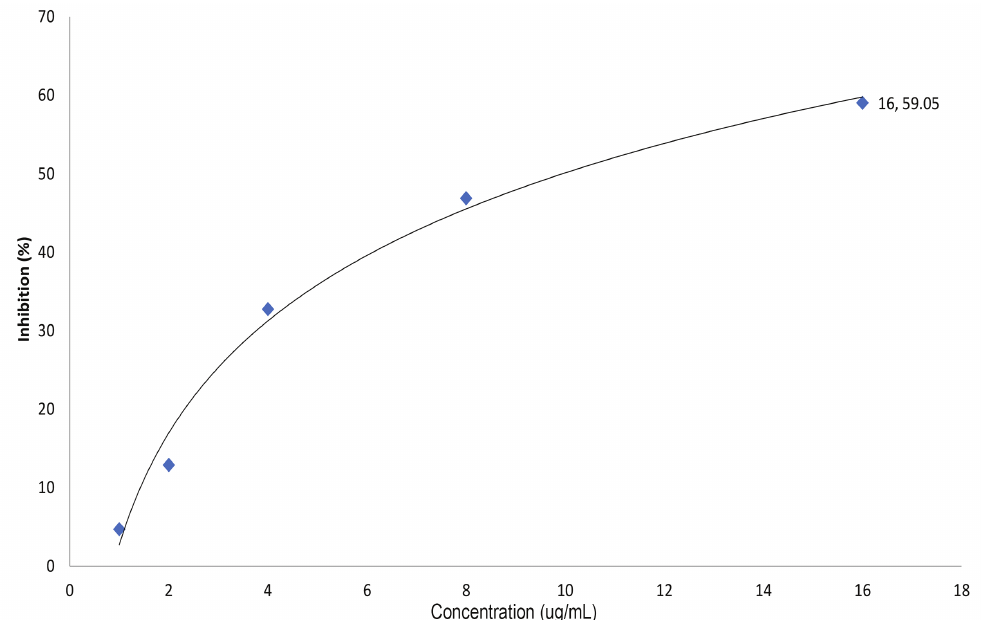
FIGURE 6 - The results of HPLC. (A) standard γ-oryzanol; (B) the sample (optimum extraction conditions, 0.7 M [Bmim]BF solution; ratio of sample/liquid 15 mL/g; extraction time, 10 min; and 30% microwave power).